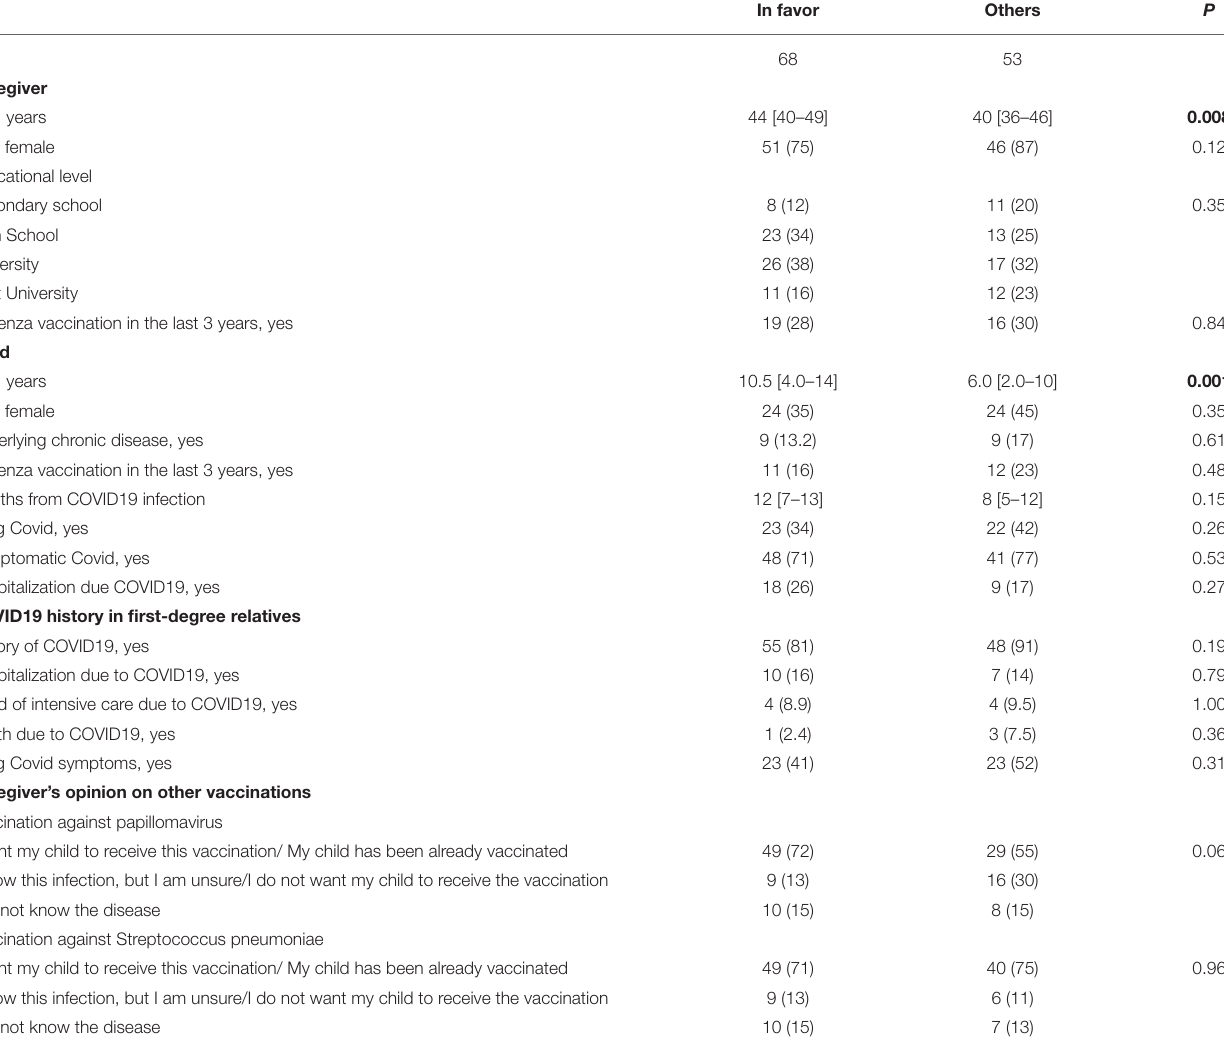
TABLE 2 | Comparison of the characteristics of caregivers in favor of COVID19 vaccination for their children and the other caregivers.